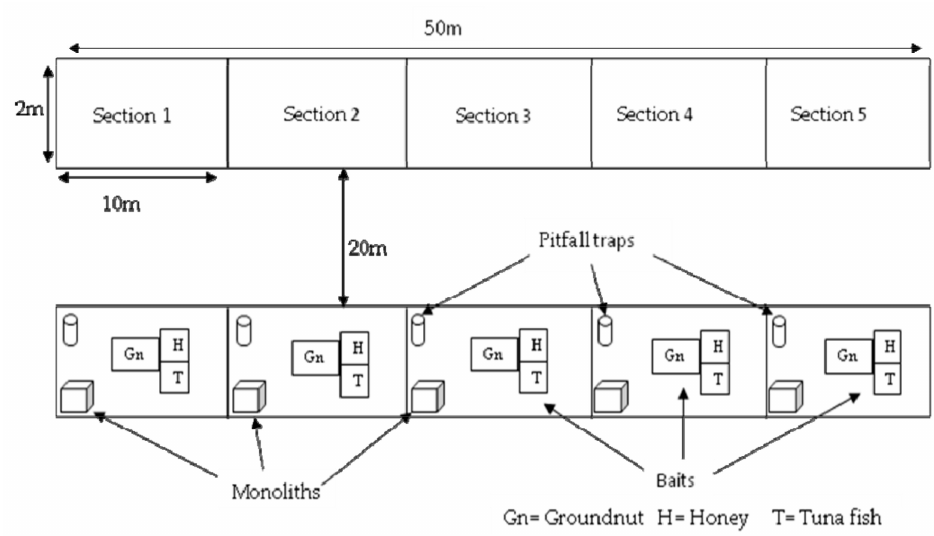
Figure 2. Schema of transect with di ff erent sampling